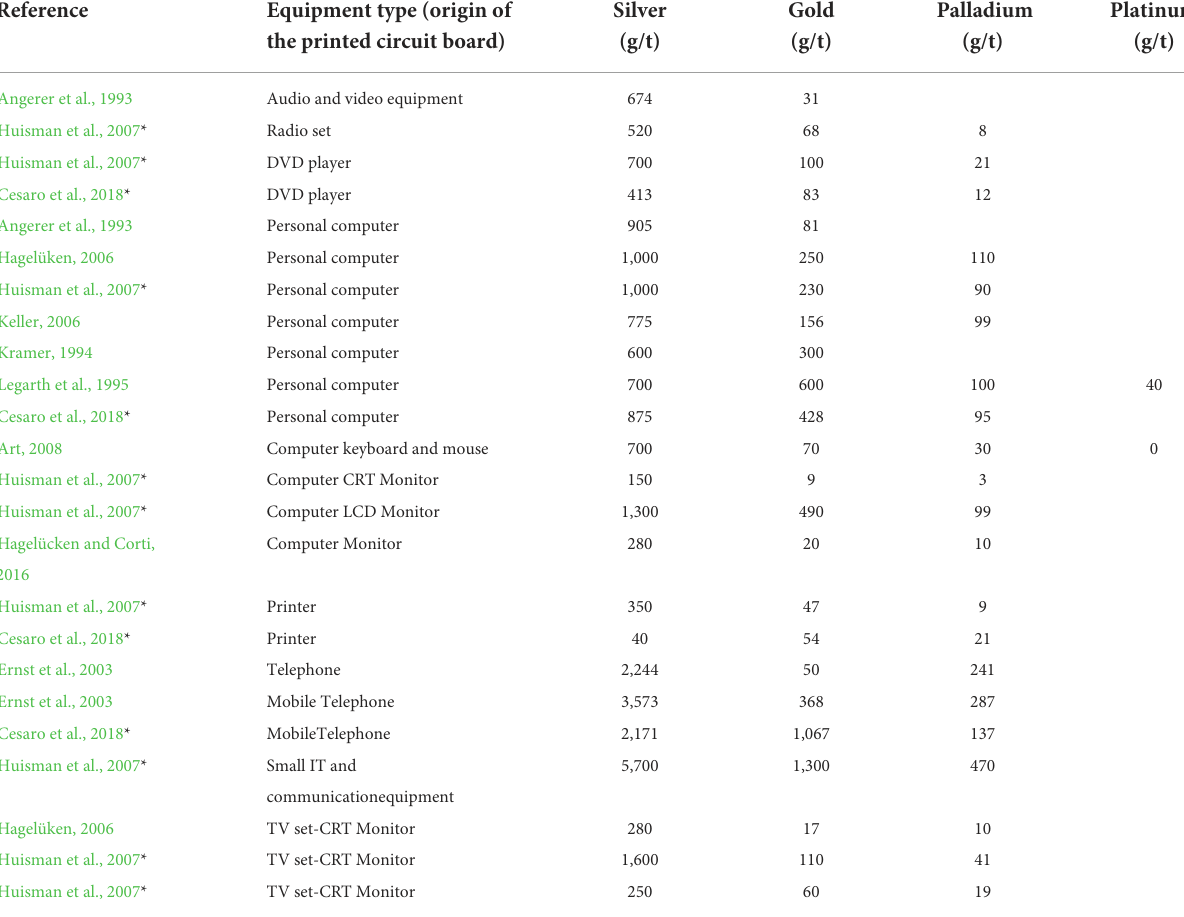
TABLE 1 Average concentration of precious metals in printed circuit boards from different equipment